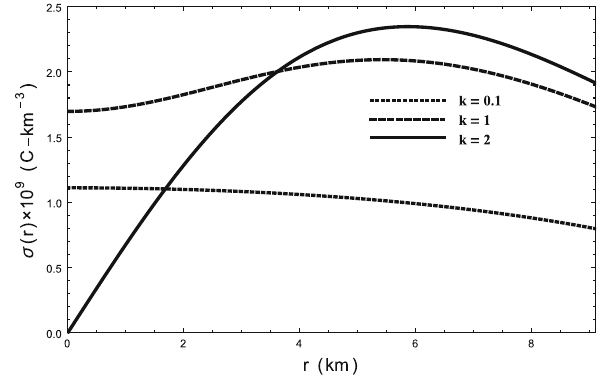
Fig. 6 Radial variation of charge density σ